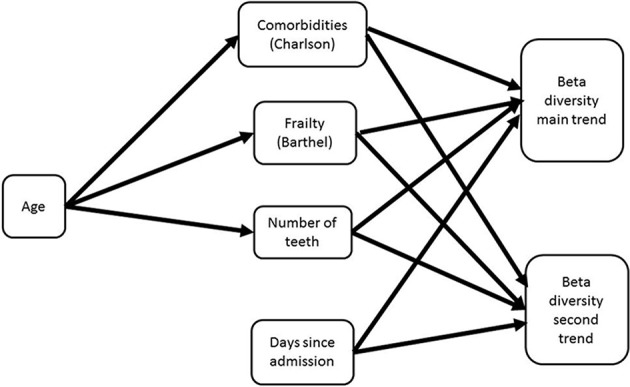
Hypothetical path diagram for a structural equation model analyzing the impacts of age, patient health status, and duration of time in hospital on the beta diversity of the oral microbiome as measured in terms of a correspondence analysis of OTUs collected from patients from admission to discharge or death (whichever occurred first).